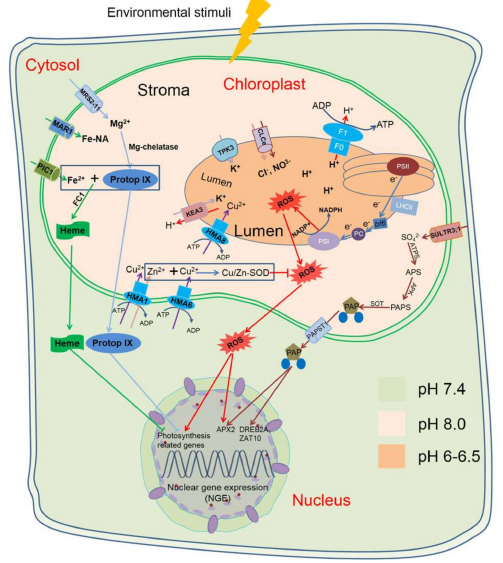
Figure 1. A schematic diagram of typical retrograde signalling pathways in plant cells. High-light stress could induce 1 O 2 accumulation which causes the accumulation of β -cyclocitral in the chloroplast. β -cyclocitral is exported to the nucleus to regulate expression of defense genes [43]. Elements in the tetrapyrrole pathways act as retrograde signals. Mg-ProtoIX and heme can both be regulated by FC1 and then transported from the chloroplasts to the nucleus to regulate photosynthesis-related genes [48,61]. Methylerythritol 4-phosphate (MEP) pathways also participate in retrograde signalling pathways, and high light could also induce methylerythritol cyclodiphosphate (MEcPP) production in chloroplasts and then regulate nuclear HPL gene expression [23]. PAP (3 (cid:48) -phosphoadnenosine 5 (cid:48) -phosphate), induced by drought and high light, could be transferred from the chloroplasts to the nucleus and regulate the expression of a set of genes [25]. Abbreviations: Protop IX, Protoporphyrin IX; FC1, ferrochelatase 1; TPK3, Tandem-pore K + selective channel3; KEA 3, Cation/proton antiporter 3; CLC, anion channel of Cl − channel (CLC) family; ROS, reactive oxygen species; PSI and PSII, Reaction centres of photosystem I and II; HMA, P-type ATPase of Arabidopsis /Heavy-metal-associated; bf6, cytochrome b6f complex; PC, plastocyanin; LHCII, Light harvesting complex; SULTR, phloem-localized sulphate transporter; ATPs, ATP sulphurylase; APS, Adenosine 5 (cid:48) -phosphosulfate; APK, APS kinase; PAPS, 3 (cid:48) phosphoadnosine 5 (cid:48) -phosphosulfate; SOT, Sulfotransferase; PAP, 3 (cid:48) -Phosphoadnenosine 5 (cid:48) phosphate; APX, Ascorbate peroxidase 2; DREB2A, Drought responsive element binding 2A; ZAT10, Salt tolerance Zinc